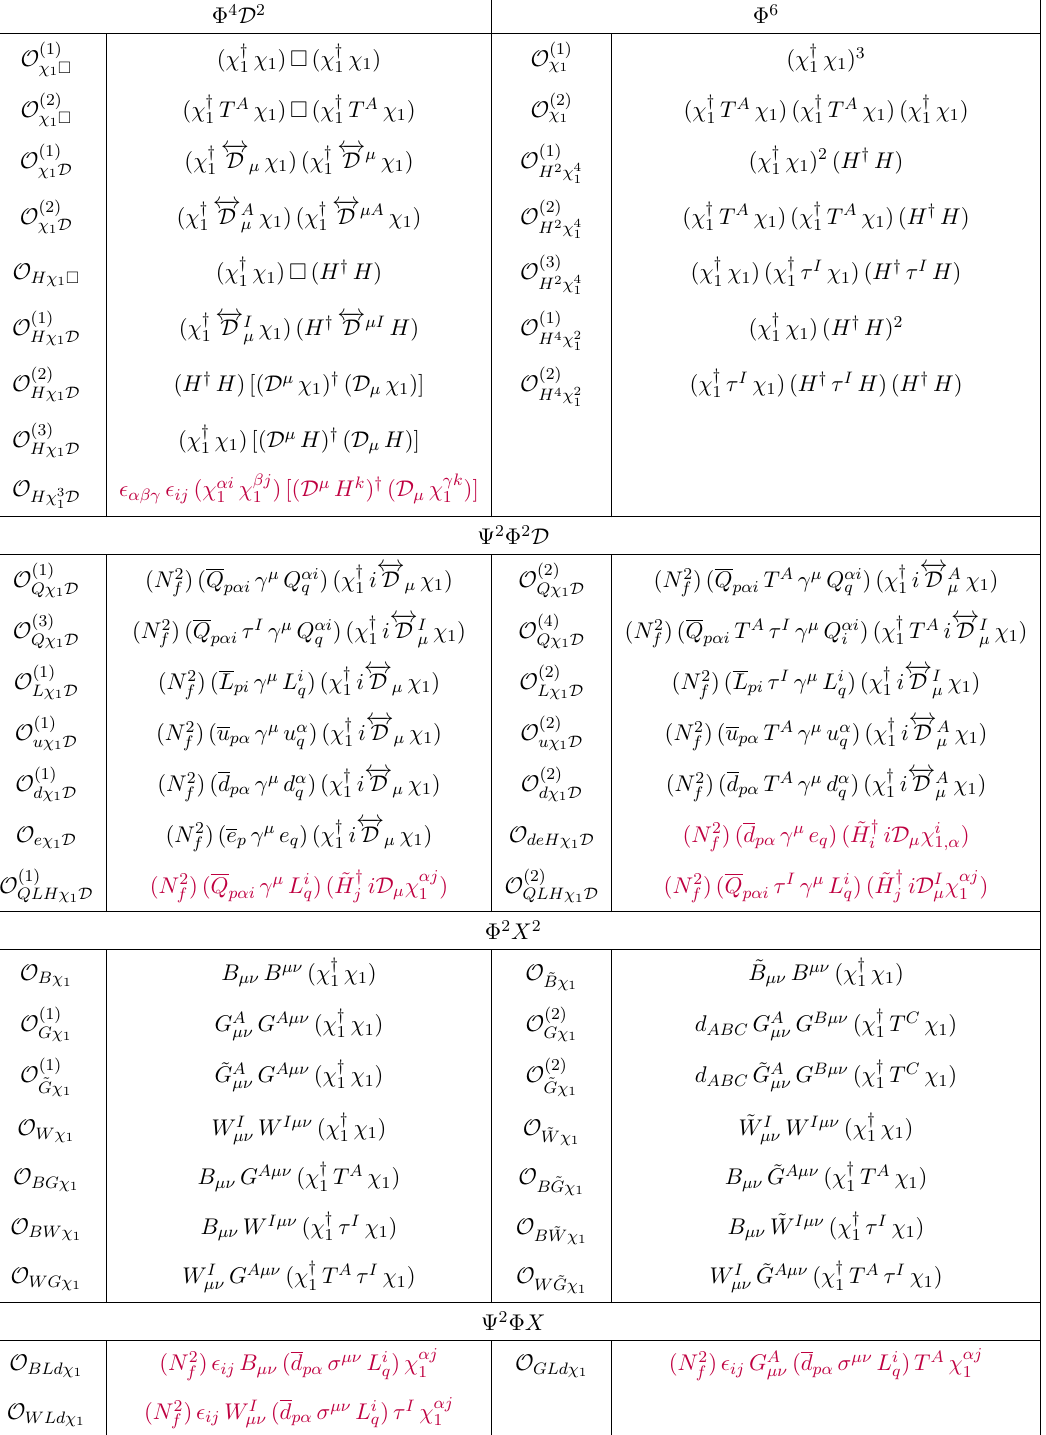
Table 20 . SM extended by Lepto-Quark ( χ 1 ): additional operators of dimension 6. Here i, j and α, β, γ are the SU(2) and SU(3) indices respectively. T A and τ I are SU(3) and SU(2) generators respectively. A, B, C = 1 , 2 , · · · , 8 and I = 1 , 2 , 3 . p, q = 1 , 2 , · · · , N f are the flavour indices. Operators in red violate lepton and baryon